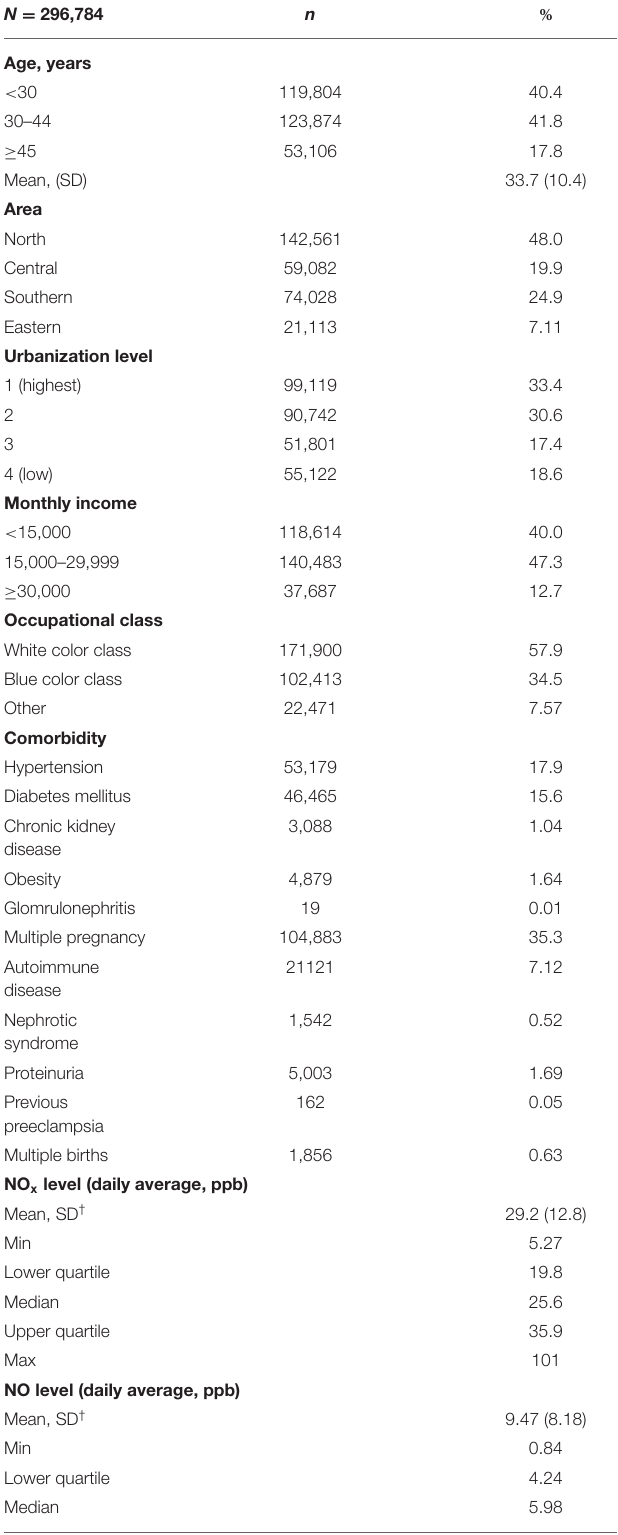
TABLE 1 | Baseline demographics and exposure of air pollutants in